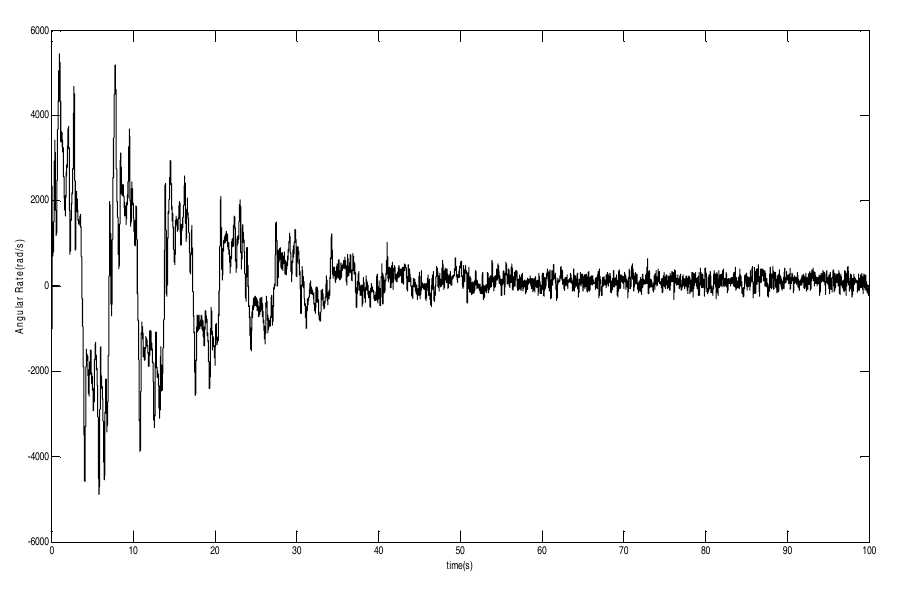
Figure 8. Convergence of angular velocity.